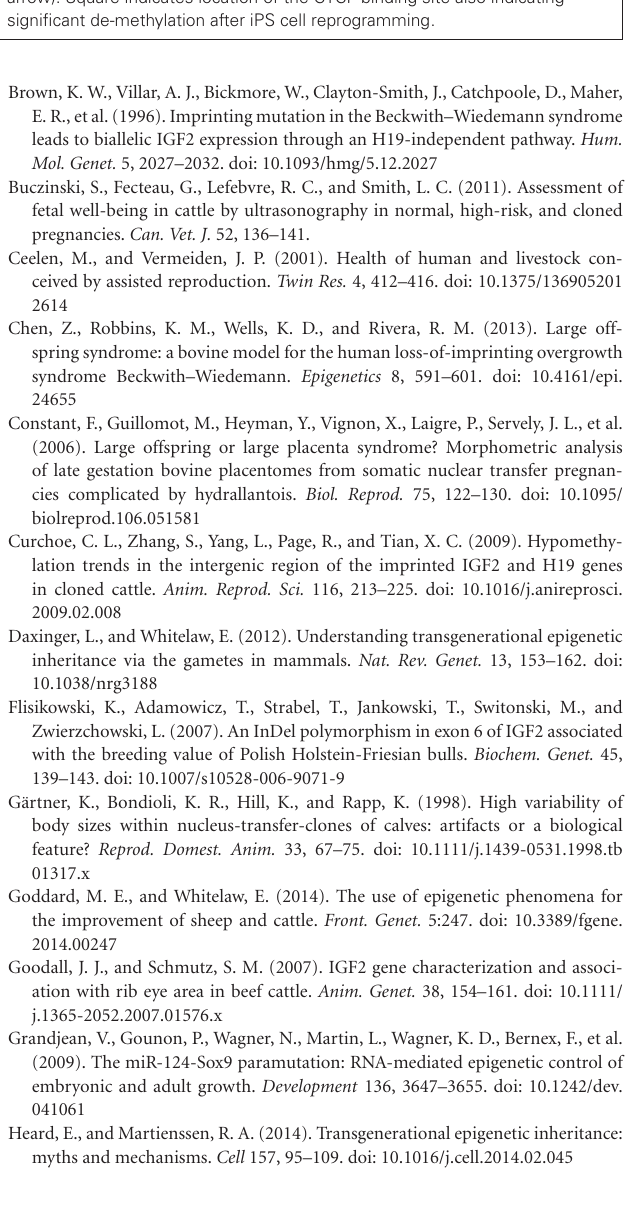
FIGURE 2 | DNA methylation pattern of the paternal H19/IGF2 DMR in hybrid fibroblasts (somatic cell) and induced pluripotent stem (iPS) cells. Circles represent methylated (black) and non-methylated (white) CpGs on the